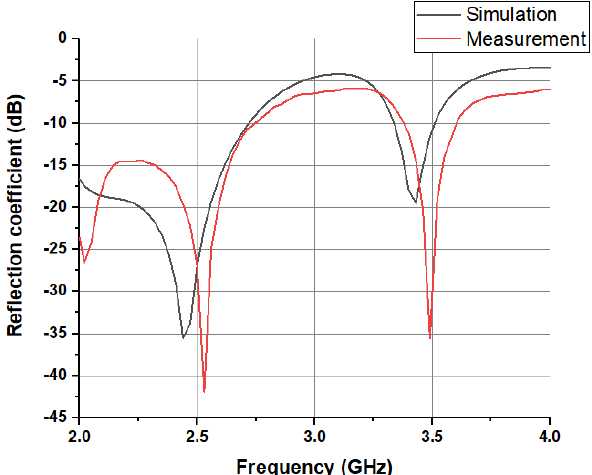
Figure 22. Simulated and measured reflection coefficients of the dual band textile antenna designed using this method.